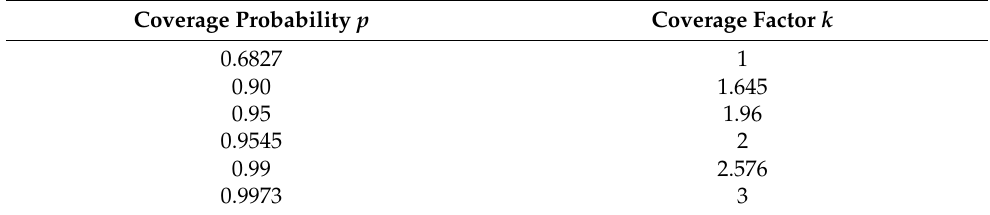
Table 2. Values of the coverage factor k that produces an interval with the coverage probability p assuming a normal